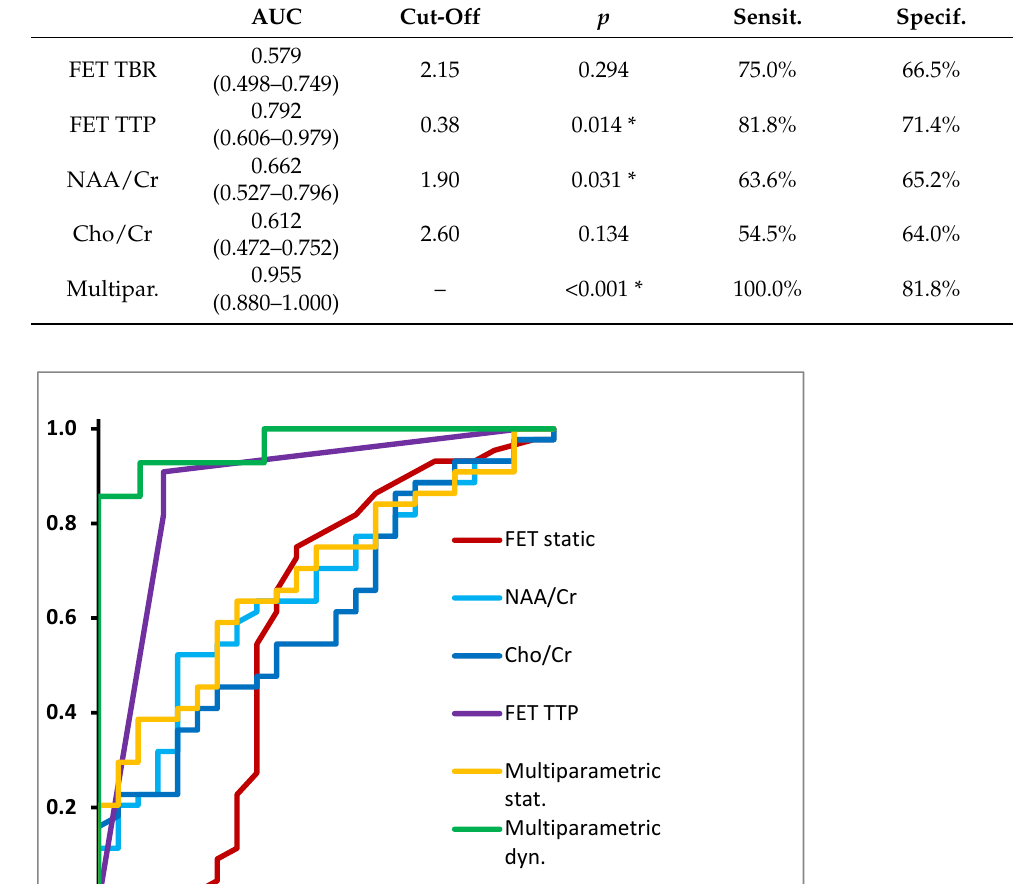
Table 4. Univariate (Kaplan – Meier) and multivariate (Cox regression) correlation between OS and imaging parameters. Significant results are marked with an asterisk.